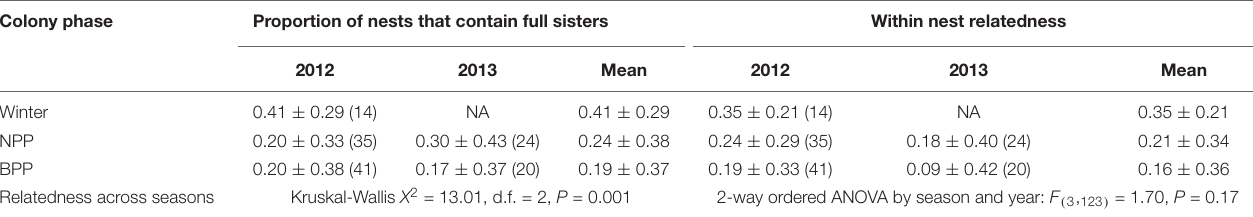
TABLE 2 | Decline in mean relatedness among nestmates from the late winter hibernation phase to nestmate provisioning phase (NPP) to brood provisioning phase (BPP). Colony phase Proportion of nests that contain full sisters